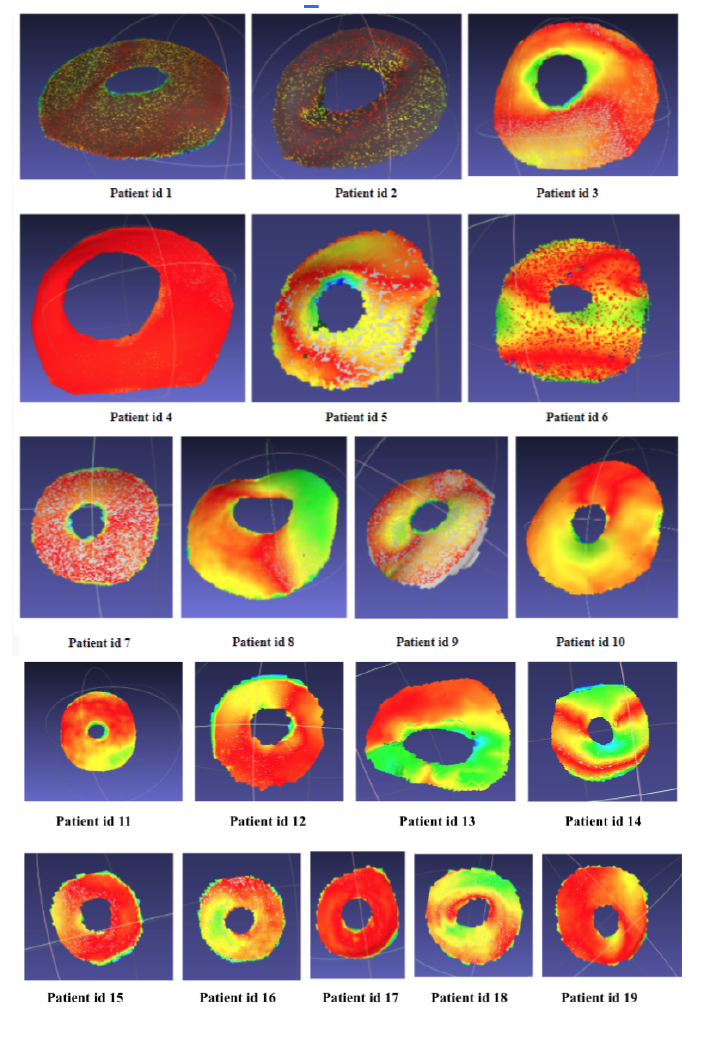
Figure 20. Collage of the Hausdorff distances of the 19 pairs of